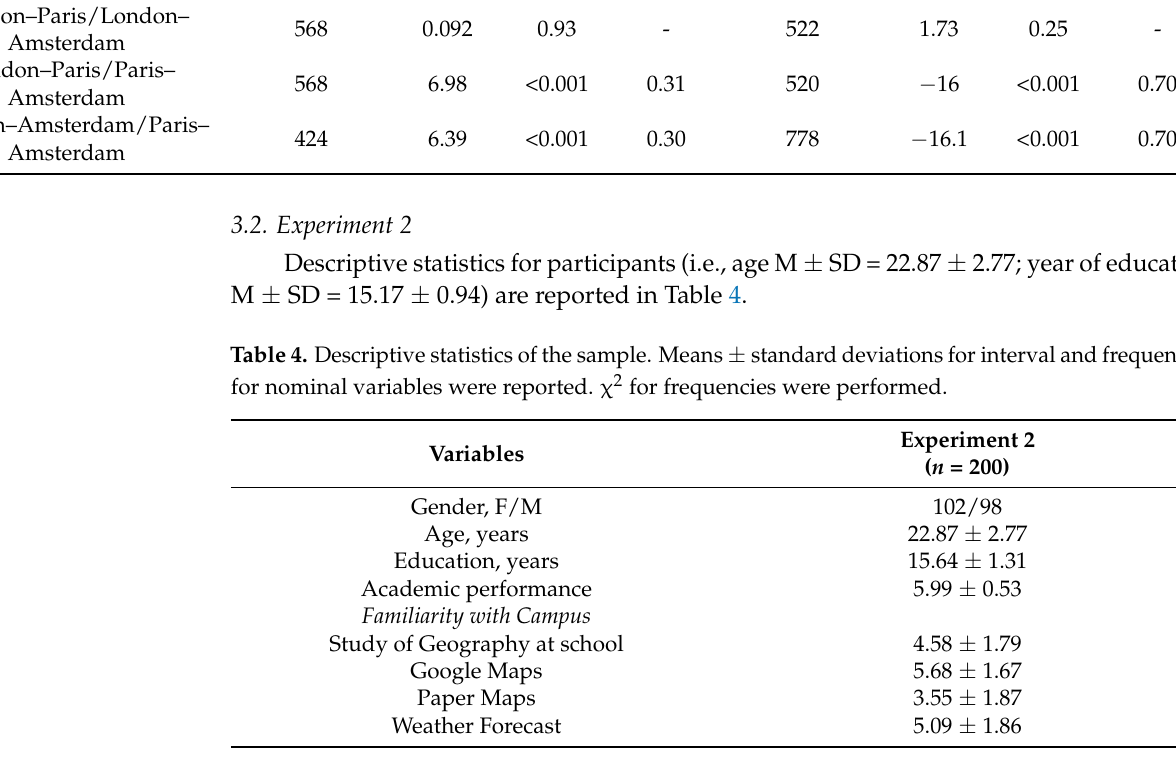
Table 3. For distance errors and positional errors in the Northern European Area, the sum of ranks, n , z score, the p -value, p , and the Cohen’s r of the Wilcoxon matched pairs test were reported. Distance Errors Sum of Positional Errors Sum of Ranks Ranks